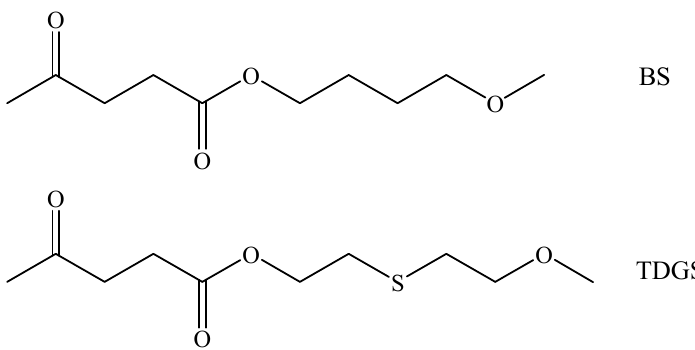
Scheme 1. Chemical formulas of BS ( above ) and TDGS ( below ) comonomeric units.